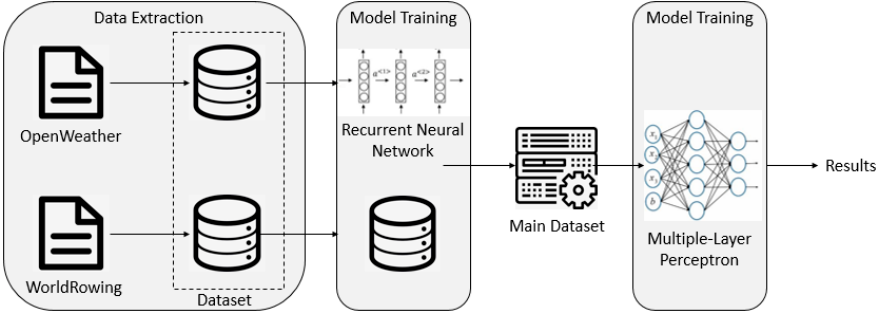
Figure 3. Methodology figure workflow.